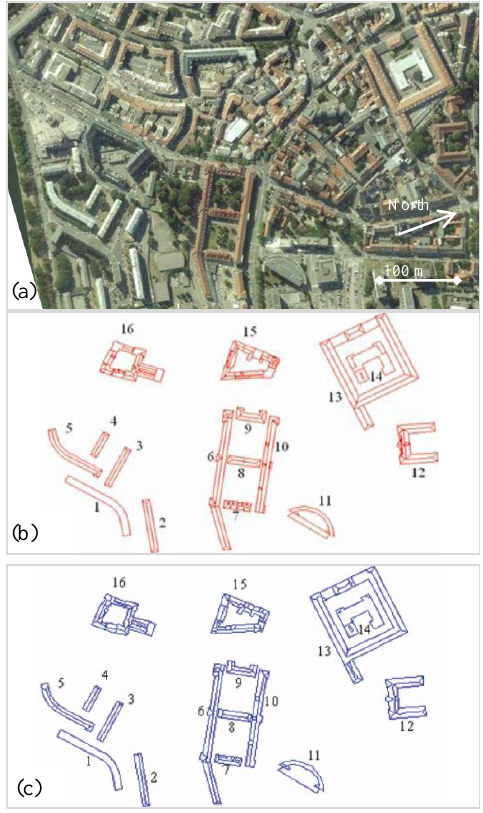
Figure 2. (a) Aerial image of a test site in Strasbourg; (b) vector model of building roofs obtained (b) by